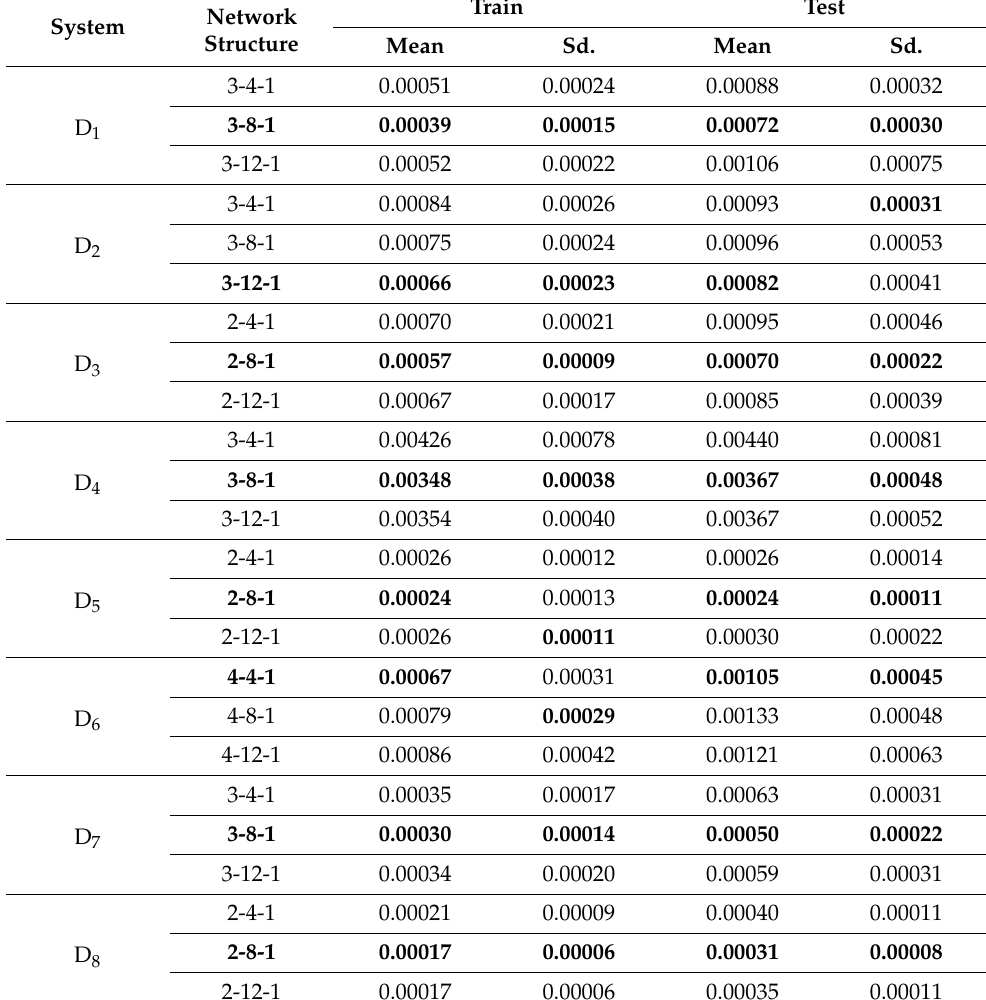
Table 10. The results obtained by using the HABCES algorithms in nonlinear dynamic system identification.